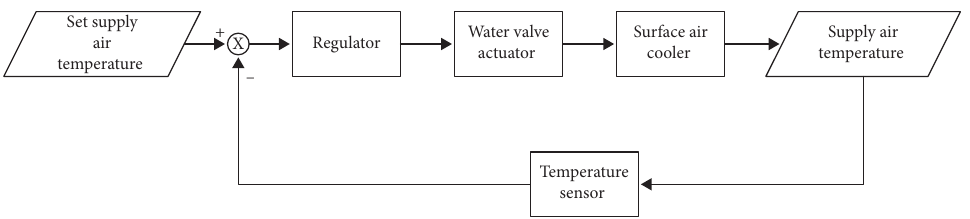
Figure 3: Diagram of the air temperature control of a VAV air-conditioning supply.